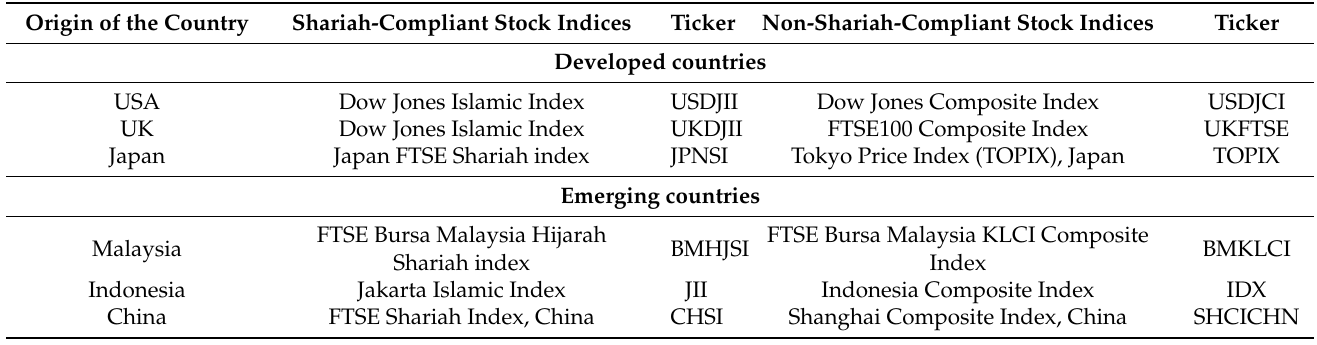
Table 1. Lists of